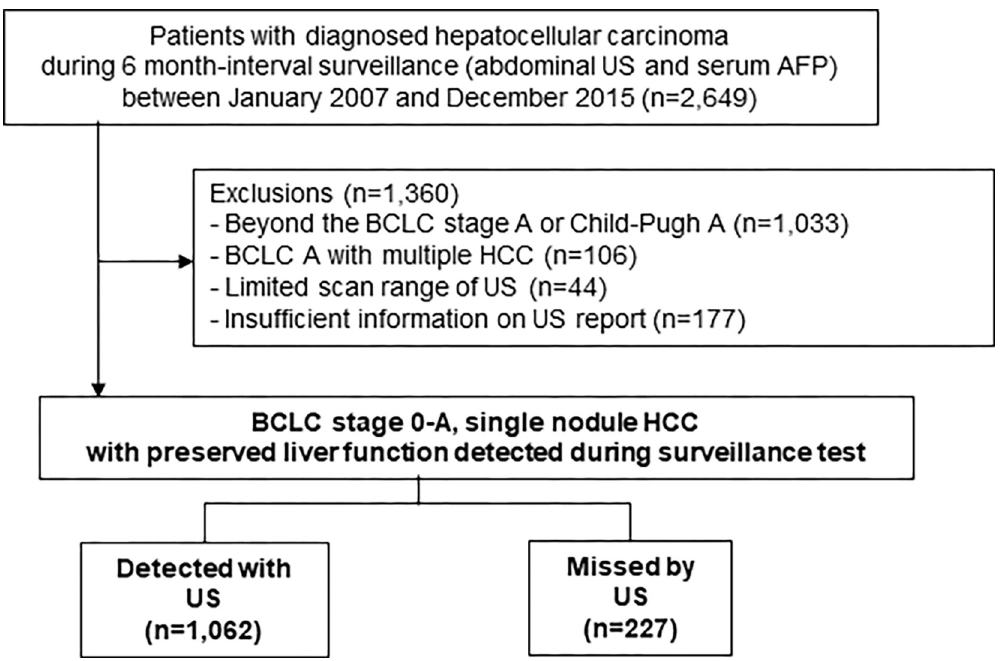
Fig 1. Study population flow sheet. AFP, serum alpha-fetoprotein; BCLC, Barcelona Clinic Liver Cancer; HCC, hepatocellular carcinoma; US, abdominal ultrasonography.